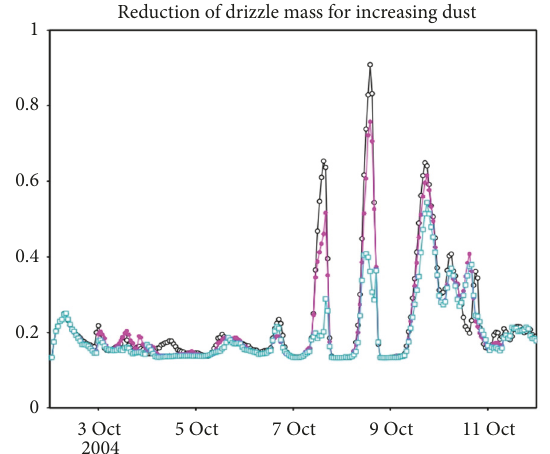
Figure 14: Comparison of total mass of water in drizzle category; black: a1d1, pink: a1d3, green: a1d10.